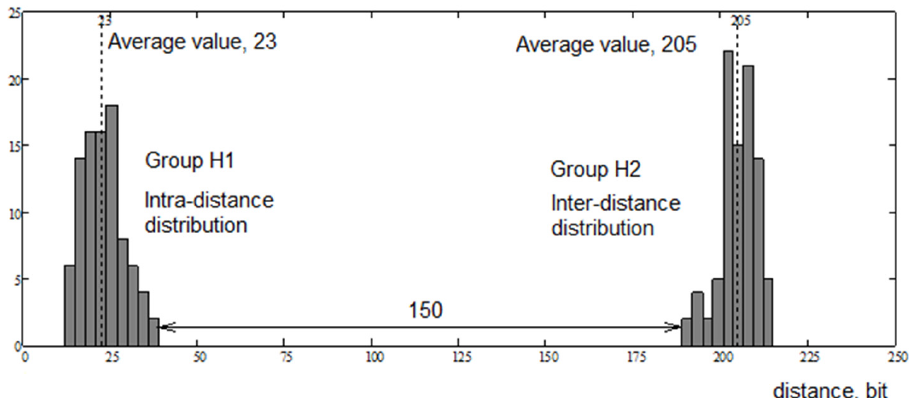
Figure 12. Histograms of the distance distribution between bit templates of one device (intradistances) and two devices (interdistances).